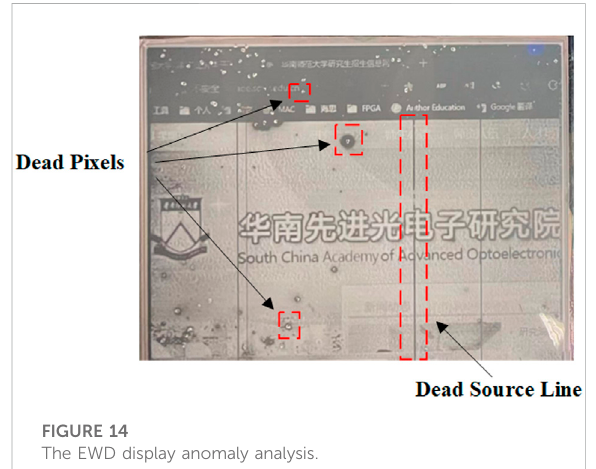
FIGURE 14 The EWD display anomaly